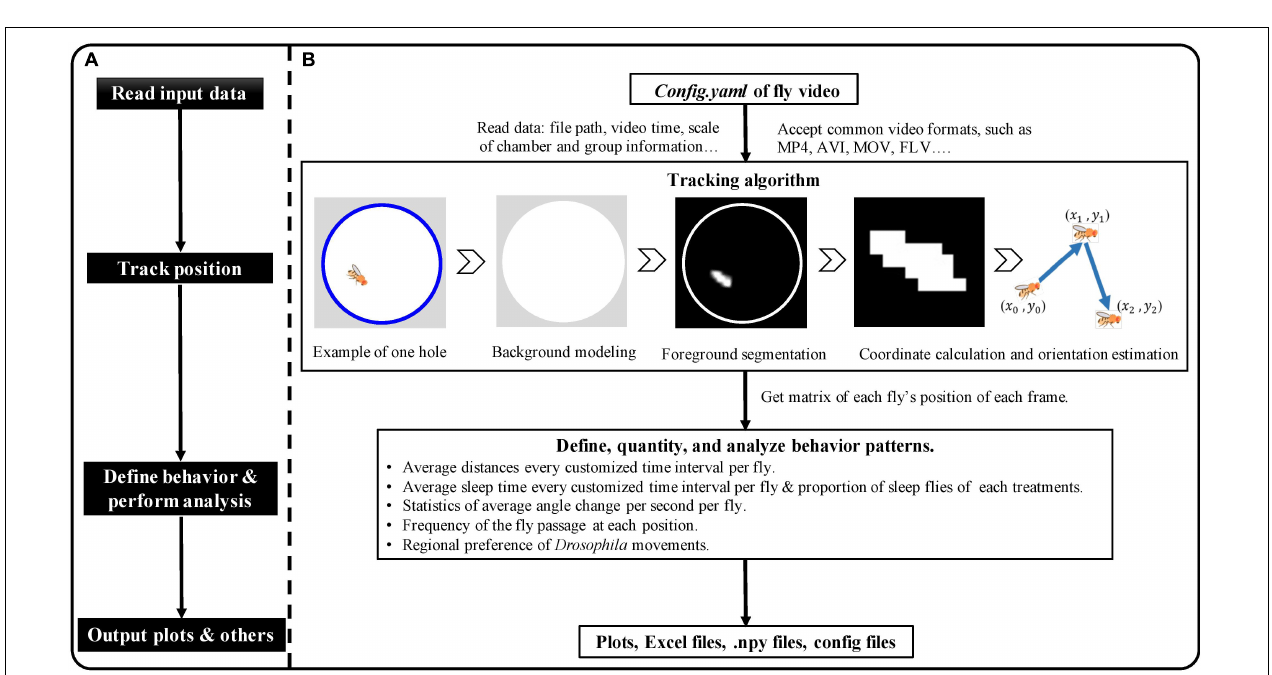
FIGURE 1 | Hardware setup of video recording system. A cartoon schematic of our shooting setup, which consists of the following parts: a standard commercial video camera, a background light, a computer, and polycarbonate (PC) antistatic transparent flat chambers. The minimum size of the fruit fly body needs to be at least 4 pixels otherwise it will be treated as noise rather than a fly.